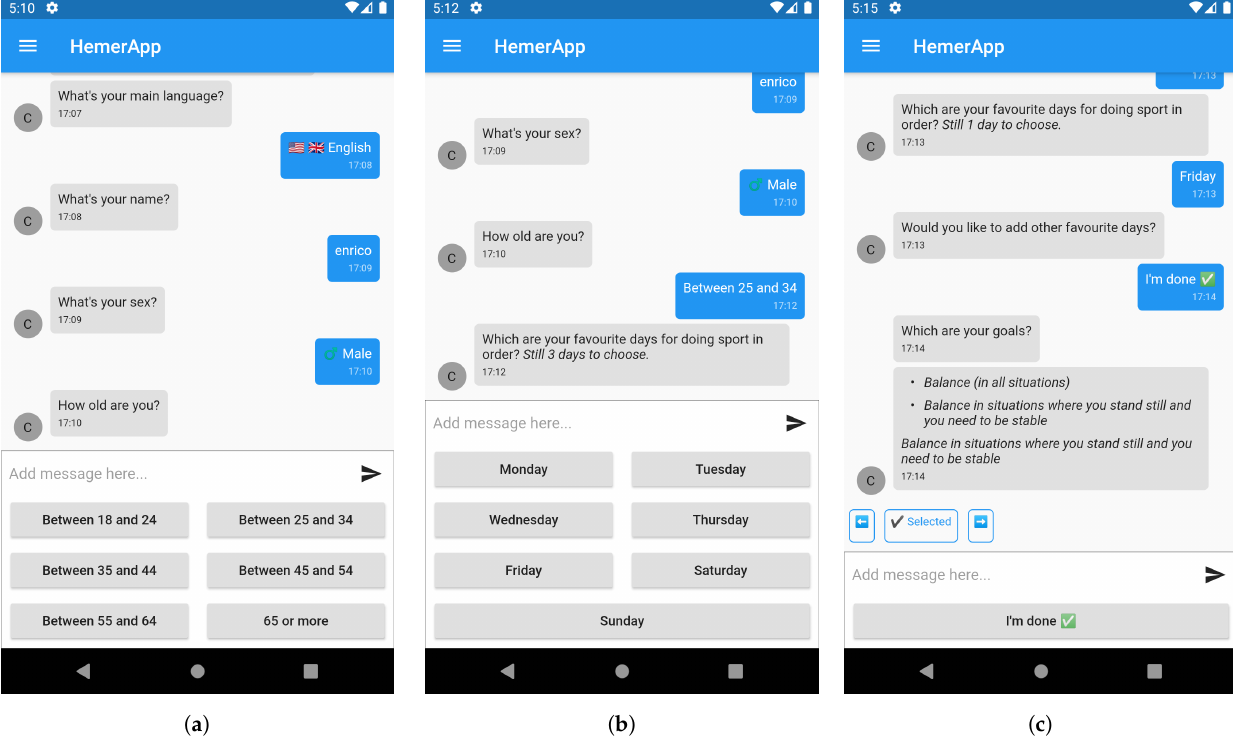
Figure 9. Demographics, preferences, and goals selection for user profiling in HemerApp. ( a ) Language and age selection. ( b ) Physical activity day preferences. ( c ) Goal(s)